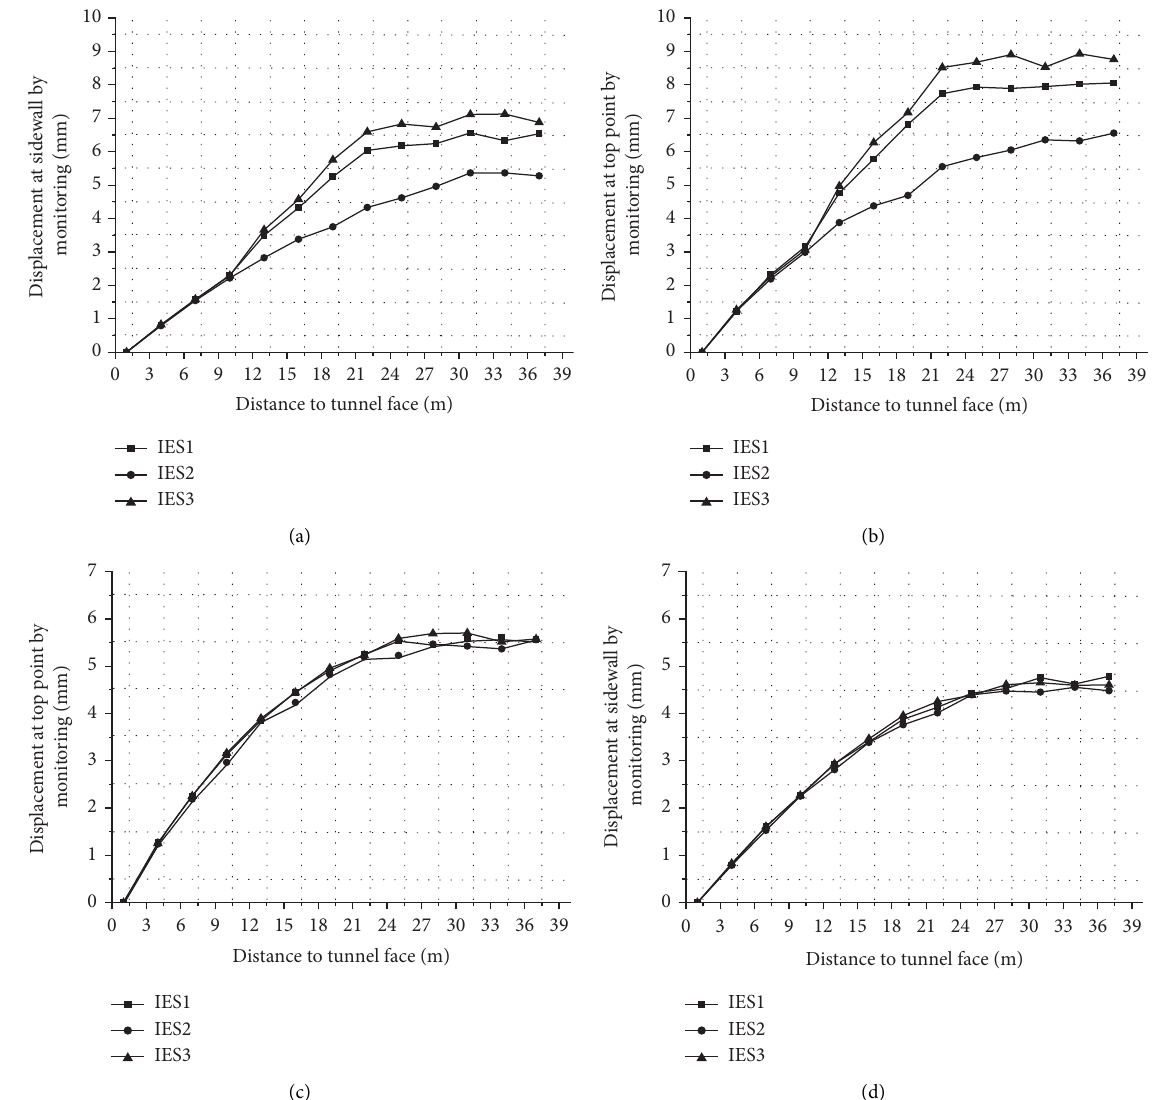
Figure 6: Measuring displacement curves of tunnels #1 and #2 under different IESs: (a) top point on tunnel #1, (b) sidewall point on tunnel #1, (c) top point on tunnel #2, and (d) sidewall point on tunnel #2.